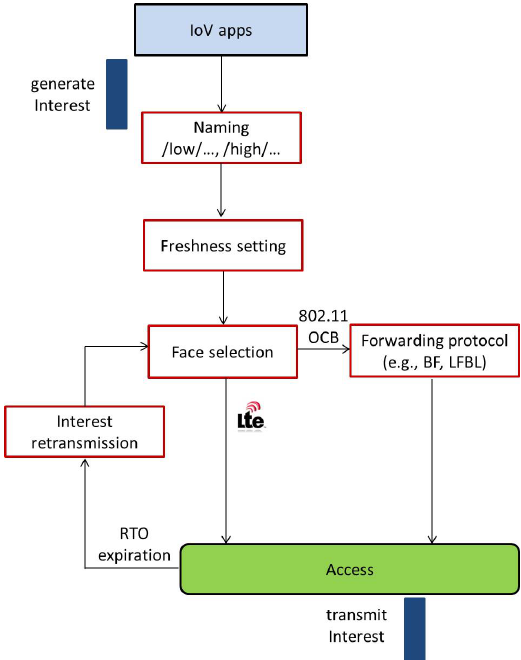
Figure 3. Interest processing at the consumer.